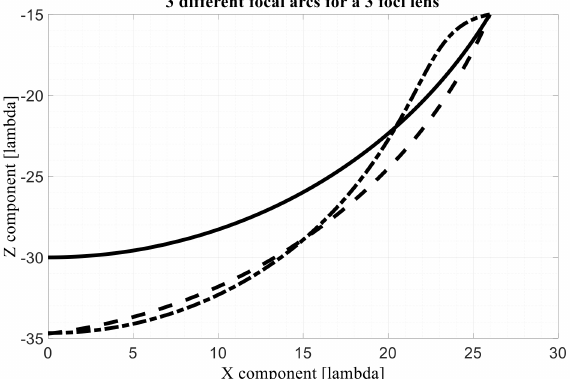
Figure 3. Three possible focal arcs in Cartesian coordinates. Continuous line: circular arc; dashed line: according to Equation (2) and linear interpolation; dash-dotted line: according to Equation (2) and local optimization.